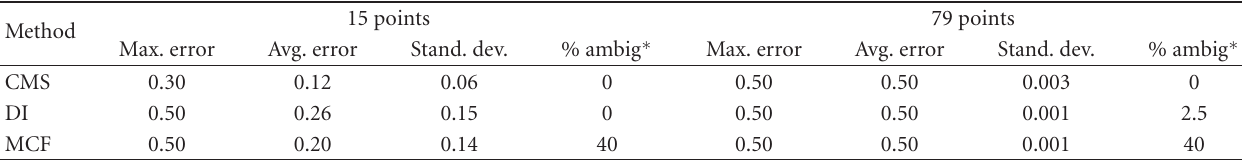
Table 3: Error in predicted damage location by each method, listed as a fraction of measurement point spacing, when 15 and 79 measurement points were used.